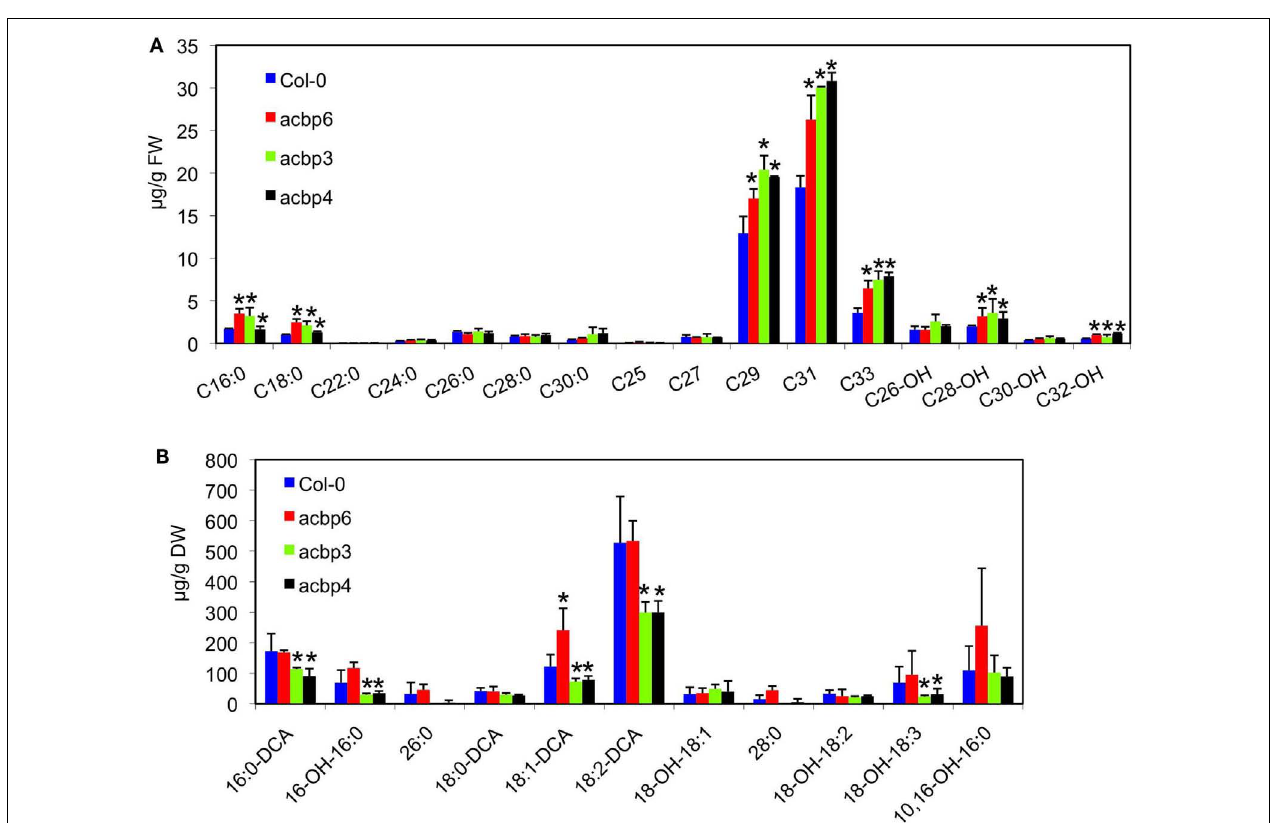
FIGURE 3 | Biochemical profiles of cuticular wax and cutin monomers in acbp mutant plants. (A) Analysis of wax components from leaves of 4-week-old Col-0 and acbp plants. C16:0-C30:0 are FAs, C25-C33 are alkanes, C26-OH-C32-OH are primary alcohols.The values are presented as a mean of five replicates.The error bars represent SD. Asterisks denote a significant difference with Col-0 ( t- test, P < 0.05). DW indicates dry weight. (B) Analysis of lipid polyester monomer content of 4-week-old Col-0 and acbp plants. Error bars in (A,B) represent SD.